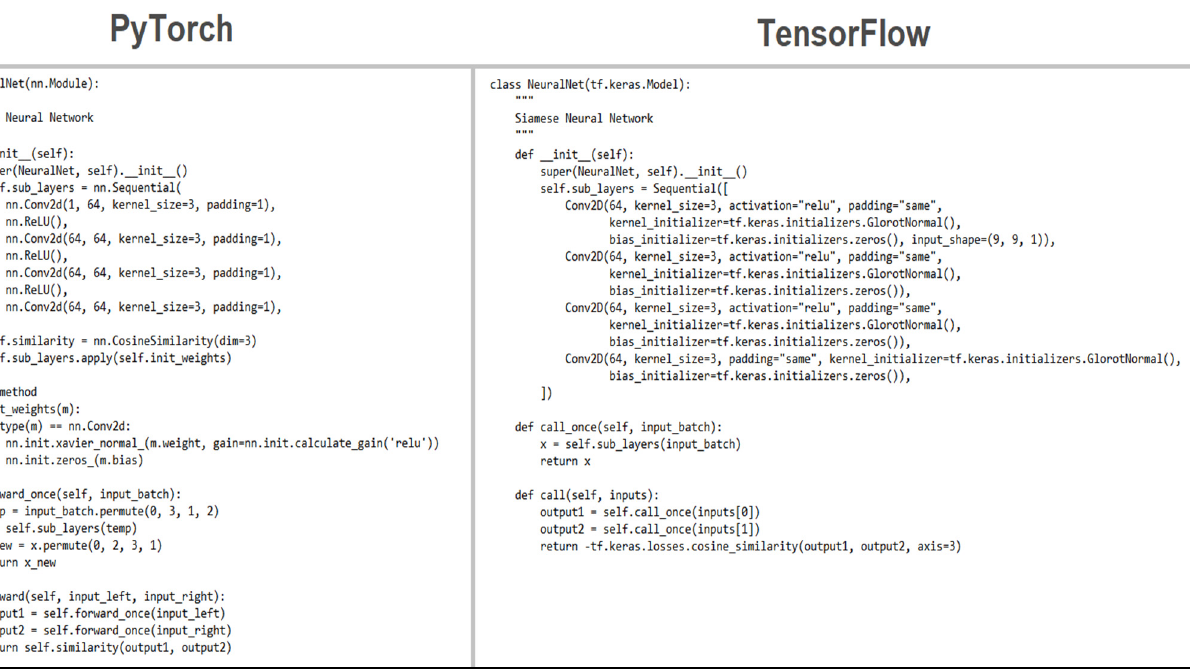
Figure 6. Network architecture comparison.